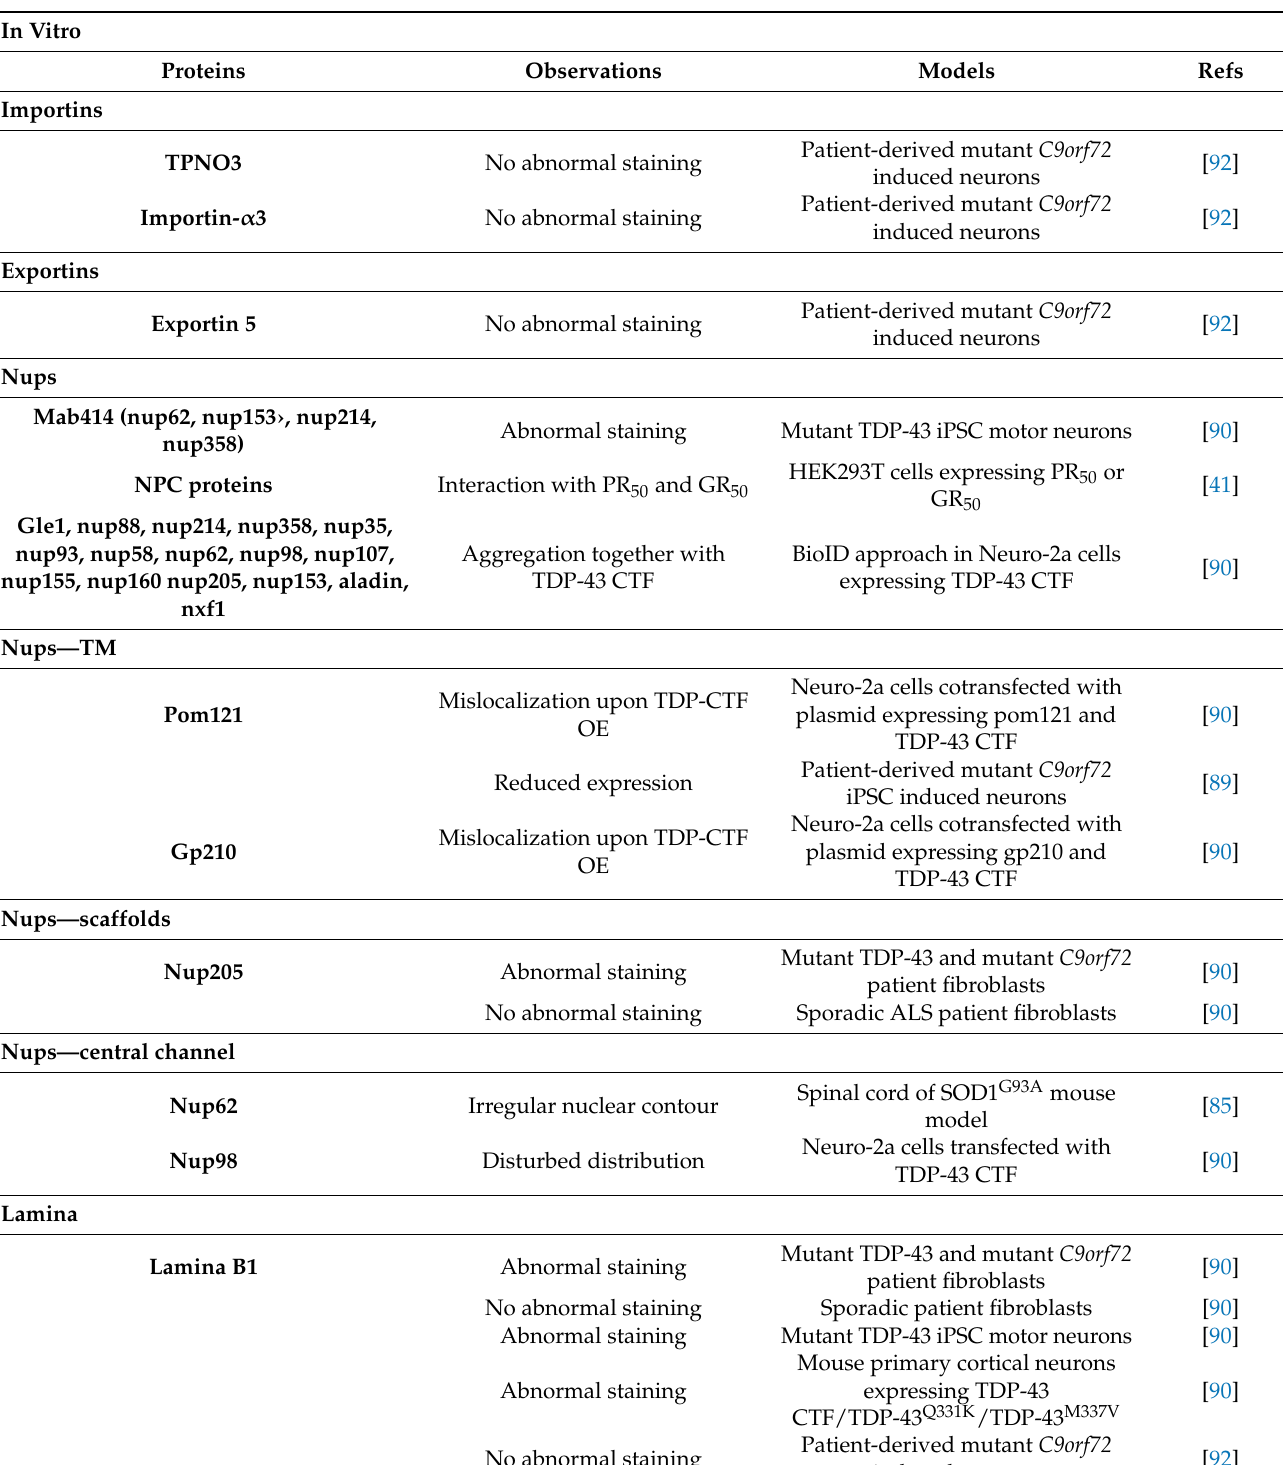
Table 2. Aberrant localization of proteins related to nucleocytoplasmic transport in ALS models. Overview of the data indicating whether or not proteins involved in nucleocytoplasmic transport were affected in in vitro and in vivo models for different forms of ALS. iPSC: induced pluripotent stem cell; CTF: C-terminal